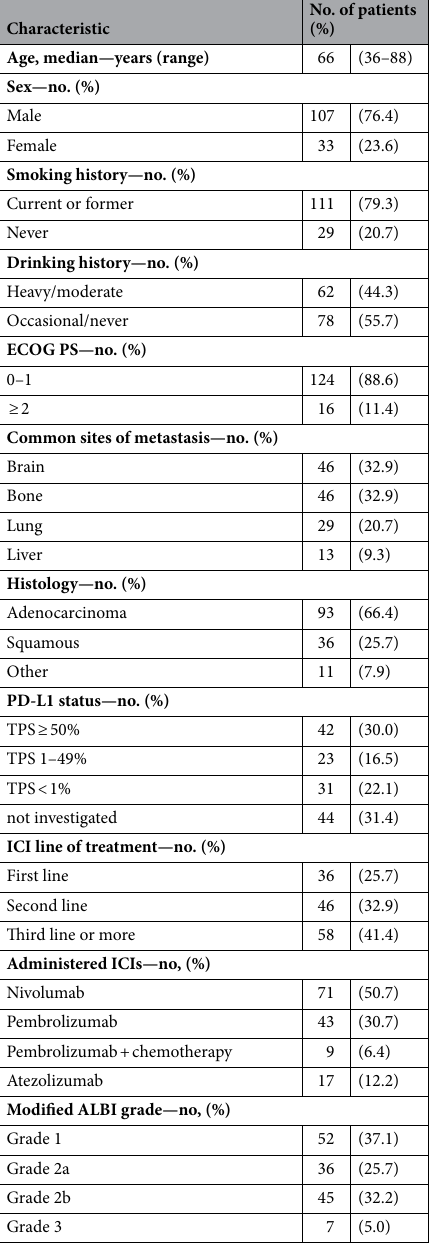
Table 1. Patients’ background characteristics (n = 140). ECOG PS eastern cooperative oncology group performance status, PD-L1 programmed cell death ligand-1, ICI immune-checkpoint inhibitor, ALBI grade albumin–bilirubin grade, TPS tumor proportion